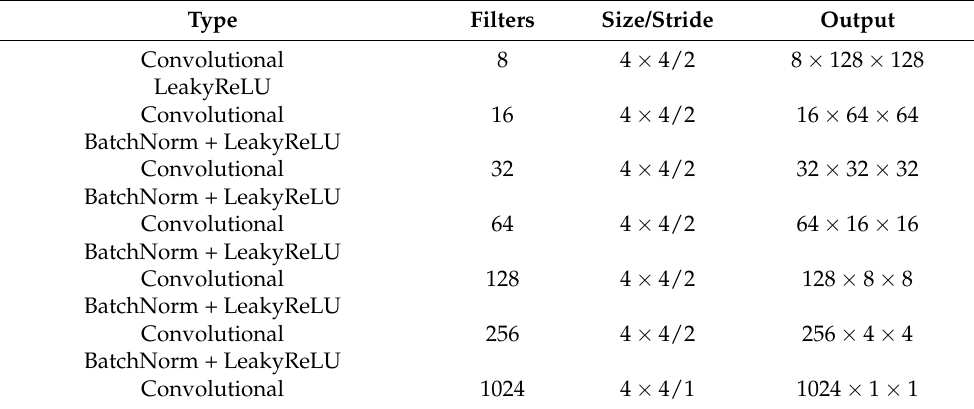
Table 1. The structure of encoder.